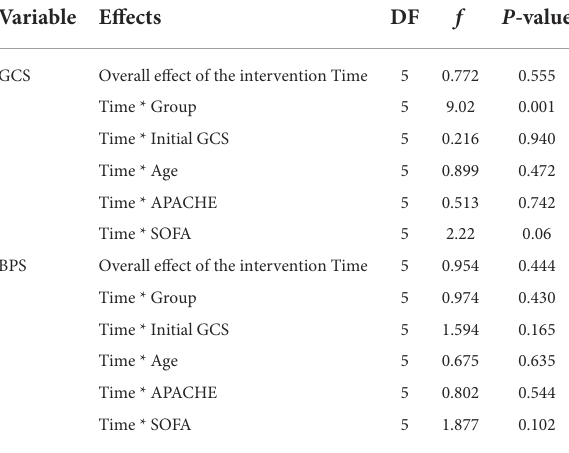
Variable Effects